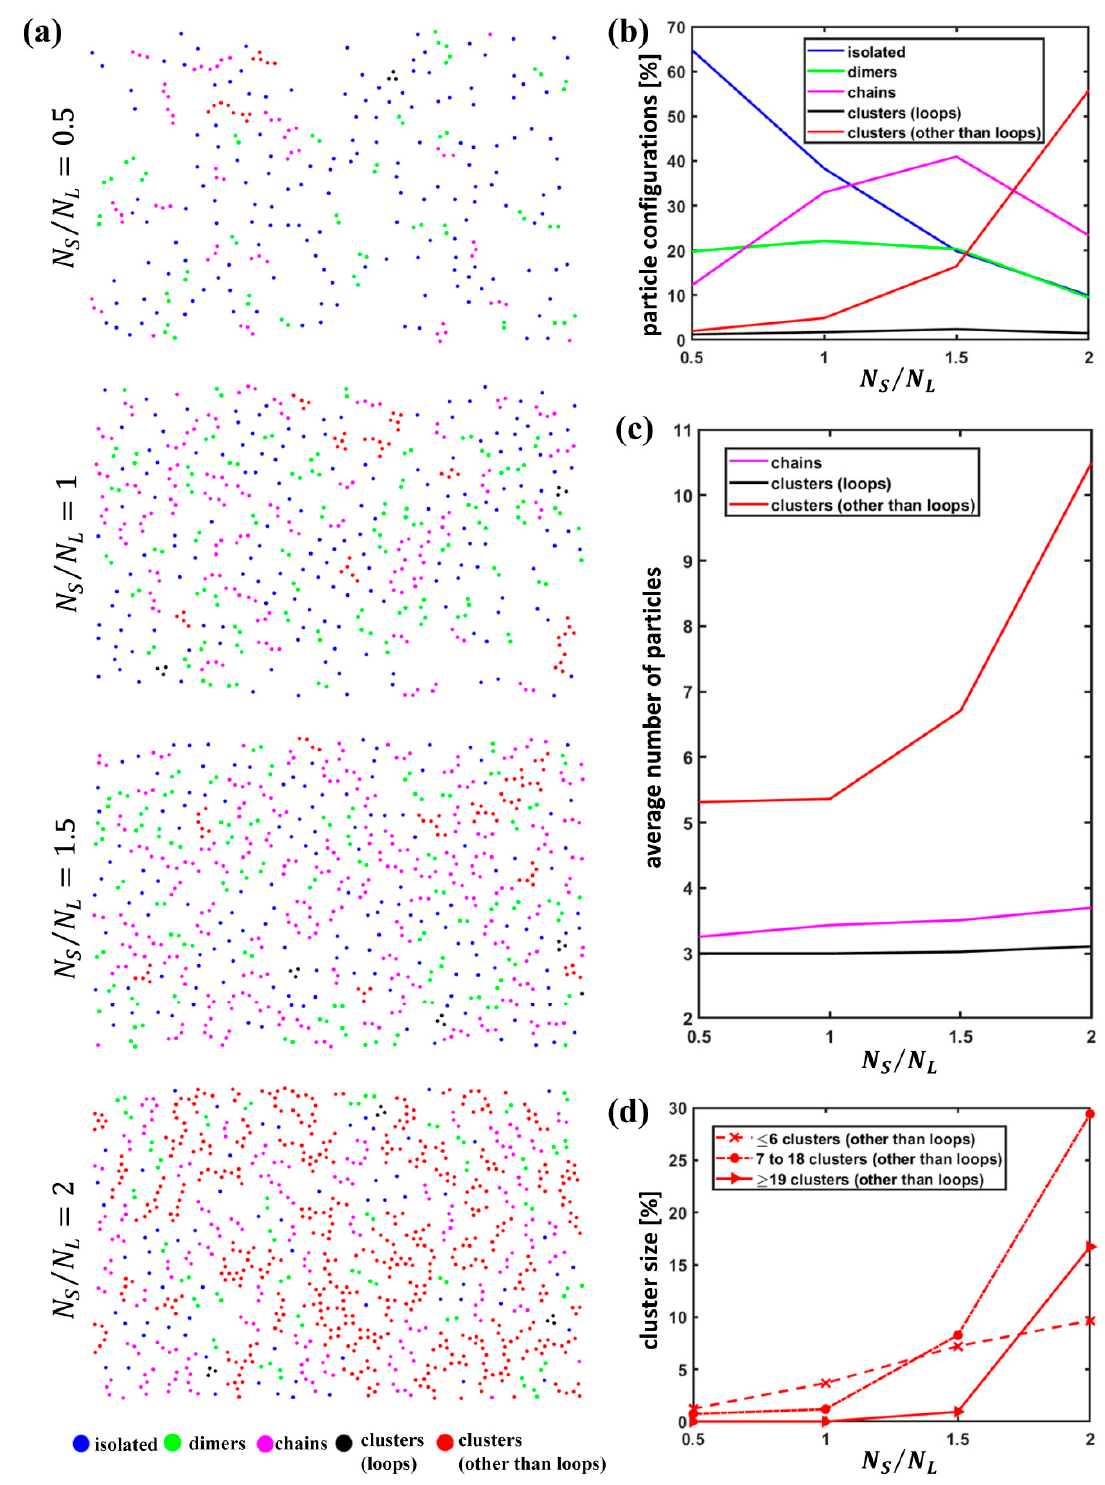
Figure 2. Classification of small particle arrangements: ( a ) Classification and color-coded representation of isolated particles, dimers, chains and clusters for variable particle number ratio N S /N L ; ( b ) percentage of the di ff erent S particle configurations for variable particle number ratio N S /N L ; ( c ) average number of S particles involved in chains, clusters identified as loops and clusters other than loops for variable particle number ratio N S /N L ; ( d ) cluster distribution according to the size for variable particle number ratio N S /N L .